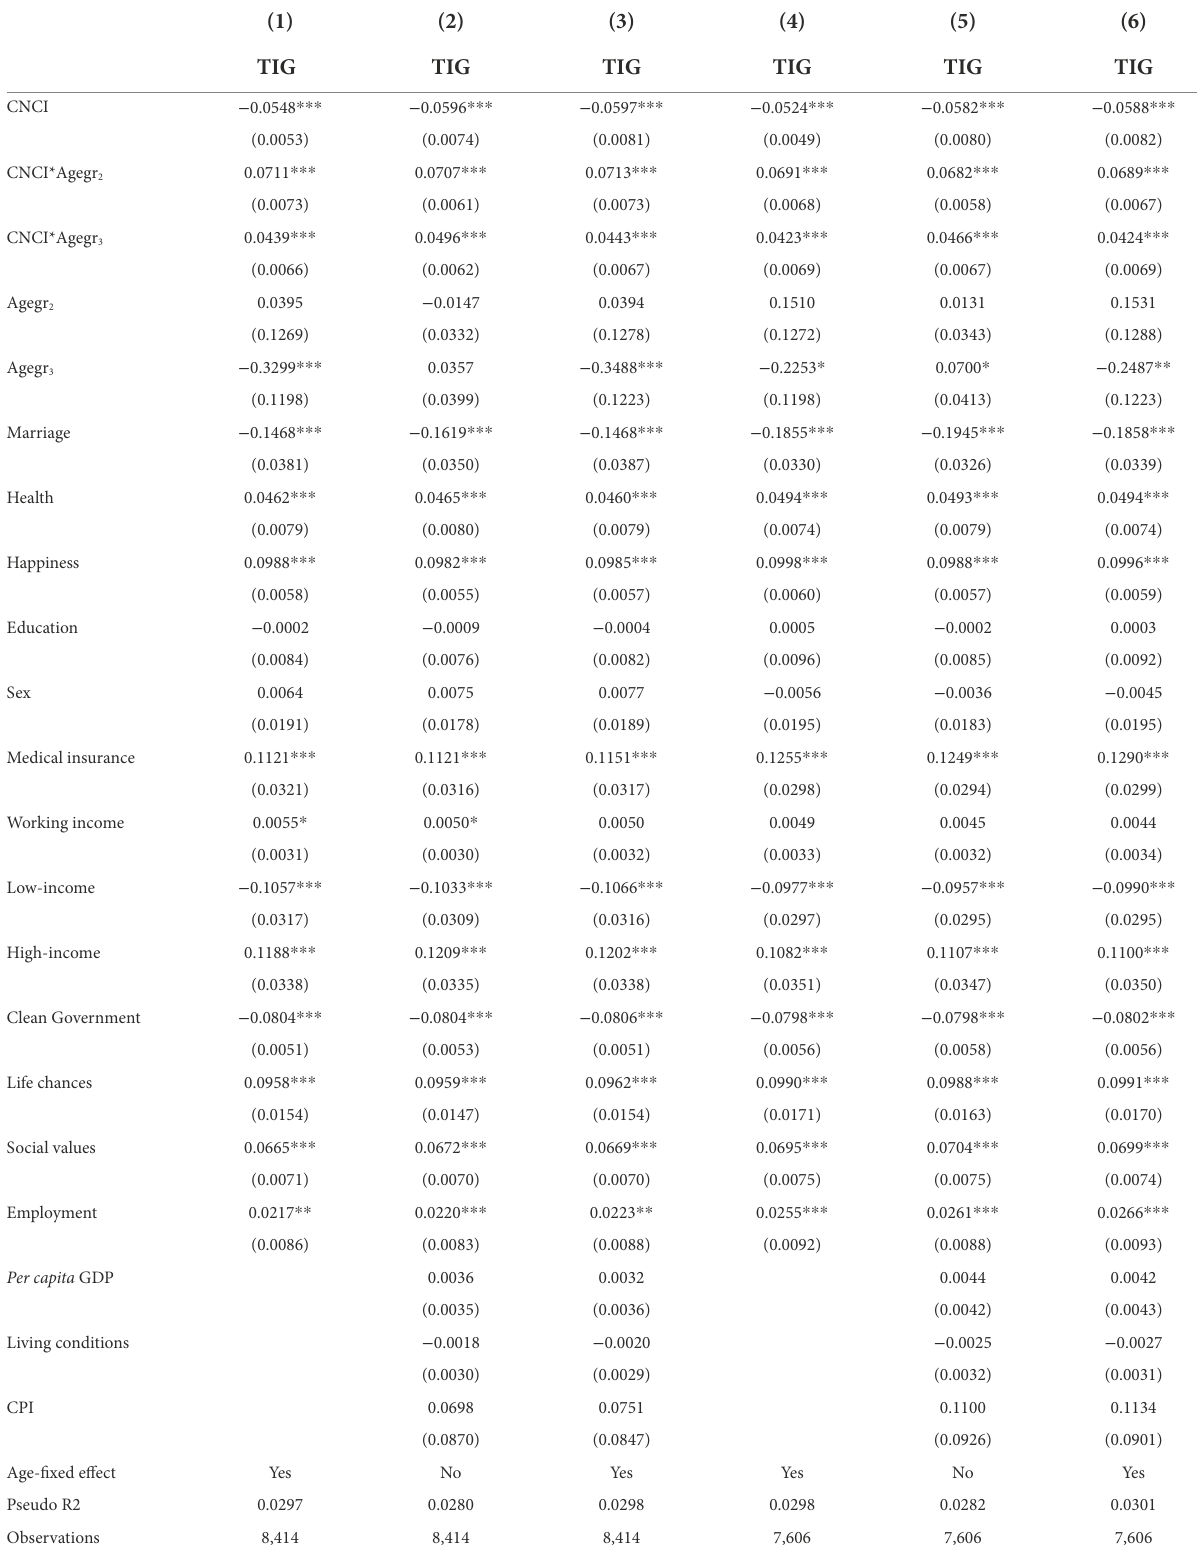
TABLE 3 Main regression